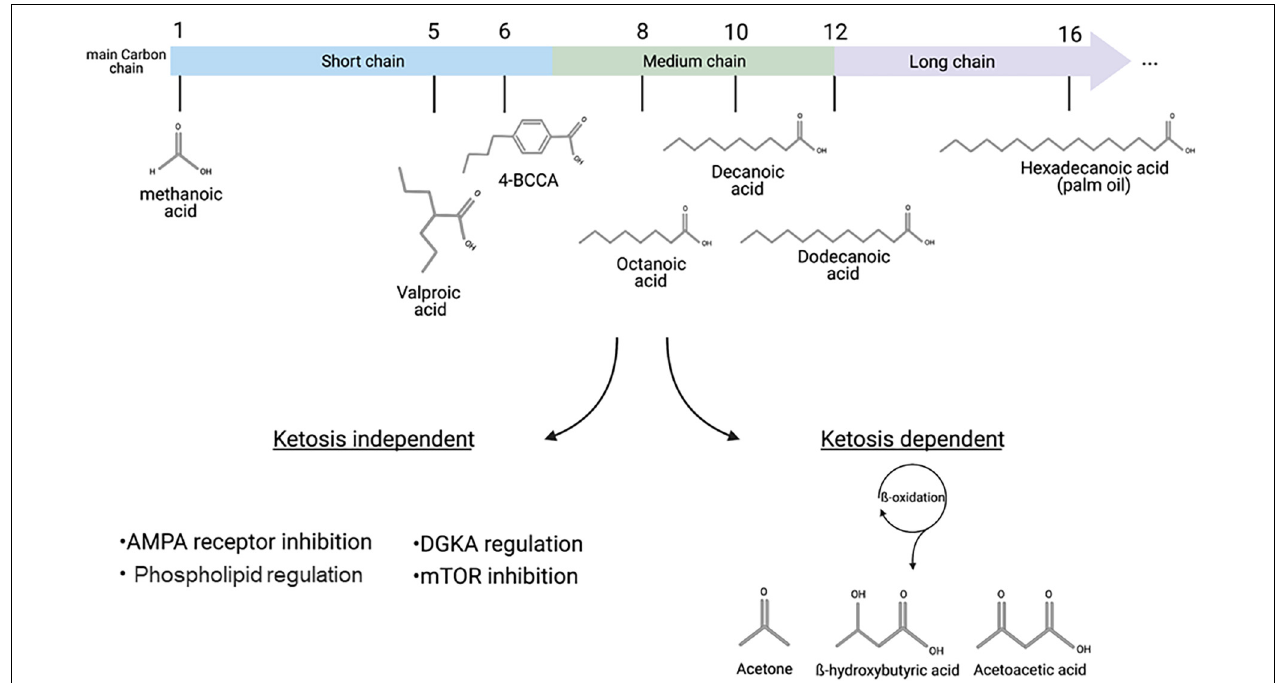
FIGURE 1 | Fatty acids classification and distinct pathways associated with therapeutic mechanisms. Main carbon chain length provides the primary classification of fatty acids, including short chain fatty acid such as valproic acid, MCFAs such as octanoic or decanoic acid, and long chain fatty acids such as hexadecanoic (palmitic) acid. Medium- and long-chain fatty acids can be metabolized in a process called ketosis, where β -oxidation leads to the formation of the three ketone bodies: Acetone, β -hydroxybutyric acid and acetoacetic acid. Recent discoveries, including those based in D. discoideum , have identified ketosis-independent mechanisms of some MCFAs, including decanoic acid and a related trans-4-butylcyclohexanecarboxylic acid (4BCCA) acid in a range of therapeutic associated mechanisms. This figure was created with